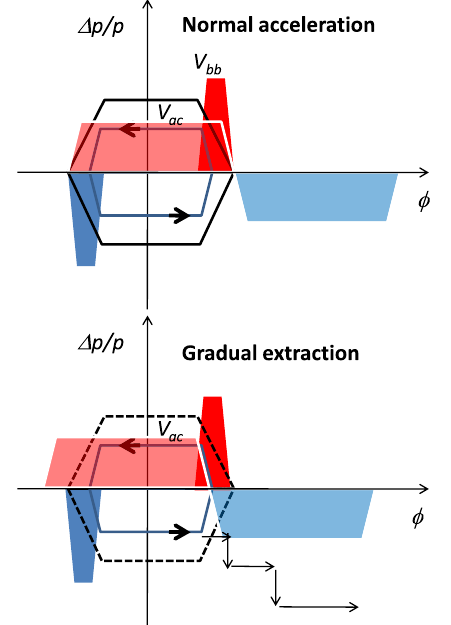
FIG. 3. Barrier bucket and acceleration voltage pulse with its reset voltage pulse (upper). Tracks of particles that have left the trapping region encircled by a broken line (lower). pulses of opposite polarity, is accelerated with a long flat voltage pulse. All voltage pulses are generated at the induction acceleration cells, which are energized by a switching power supply employing solid-state switching elements such as SiC devices [7]. Since the solid-state switches are triggered by the gate signal, the necessary